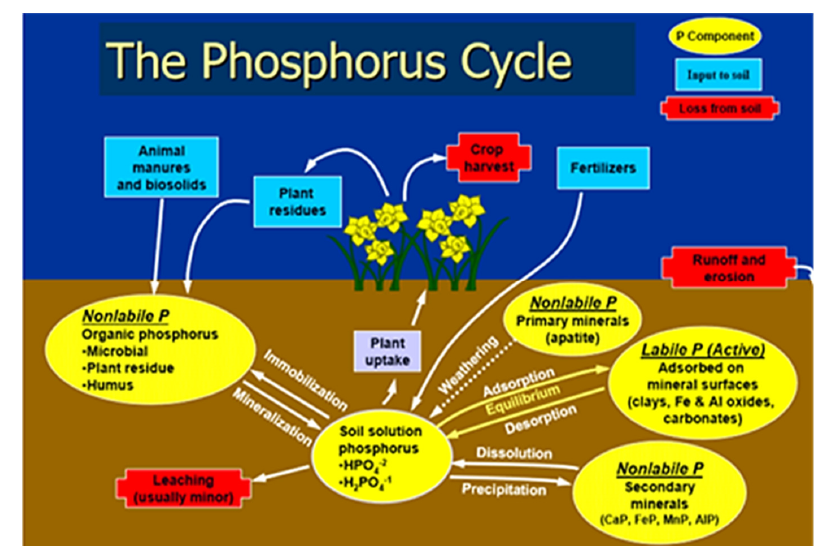
Figure 2. The phosphorus cycle in soils Source: